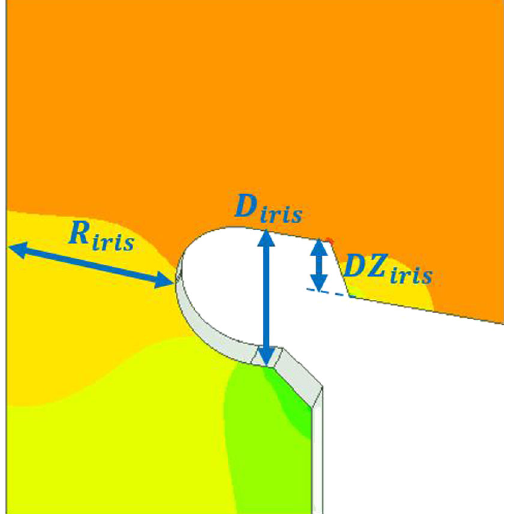
FIG. 5. Coupling iris model. The electrical field is in loga- rithmic scale.